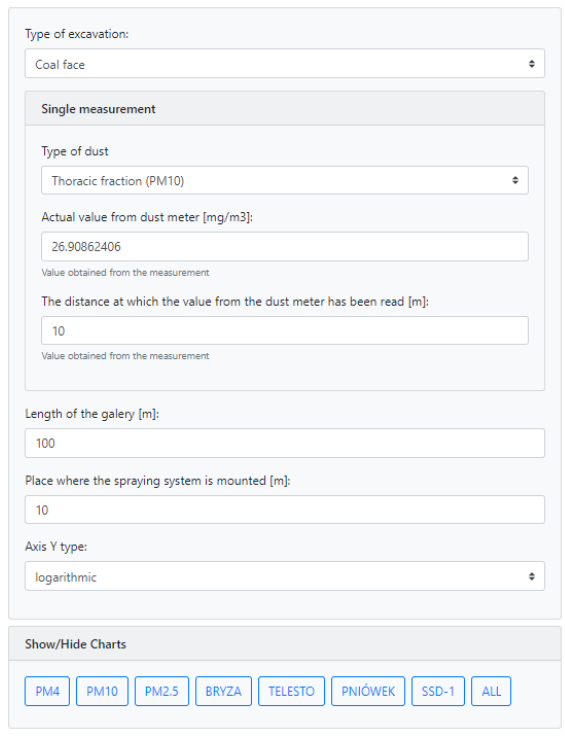
Figure 22. Window on the panel for entering the input data for prediction of dust concentration.